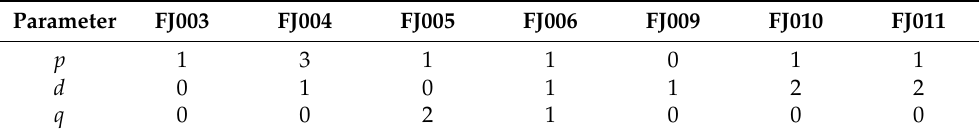
Table 1. The optimal parameters of the ARIMA model for the displacement data of the Huanglianshu